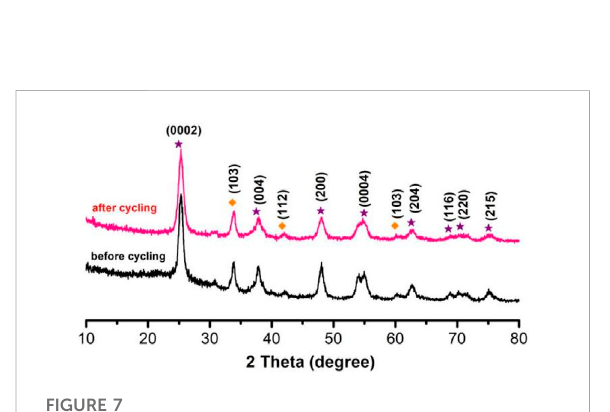
FIGURE 7 XRD of TiO 2 NPs/h-BN before and after thermal catalysis. TABLE 1 Recycling and stability of TiO 2 NPs/h-BN.